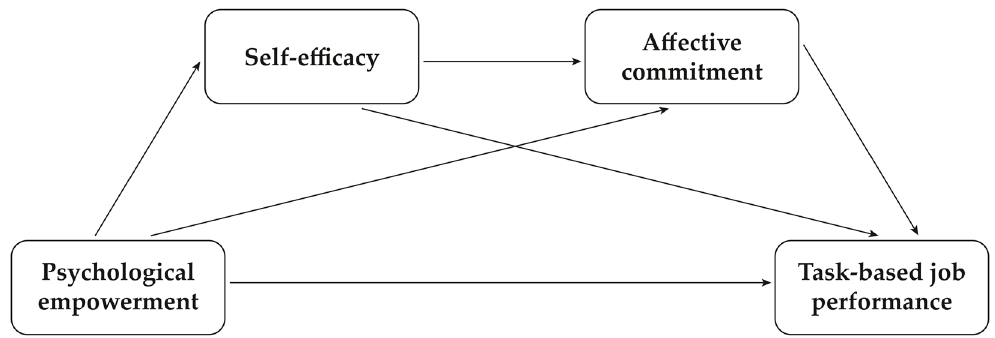
Figure 1. Research